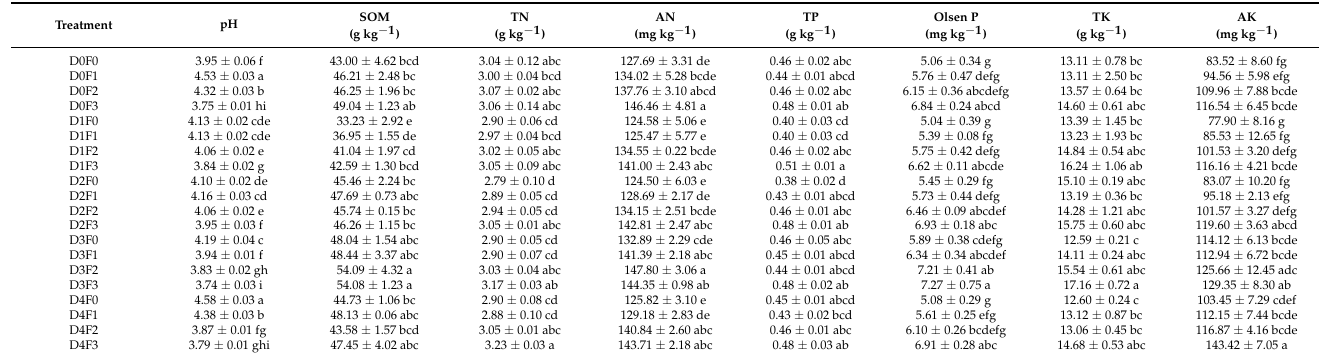
Table A2. Effects of fertilizer and density management on the soil nutrients’ properties in bamboo forests (2019).